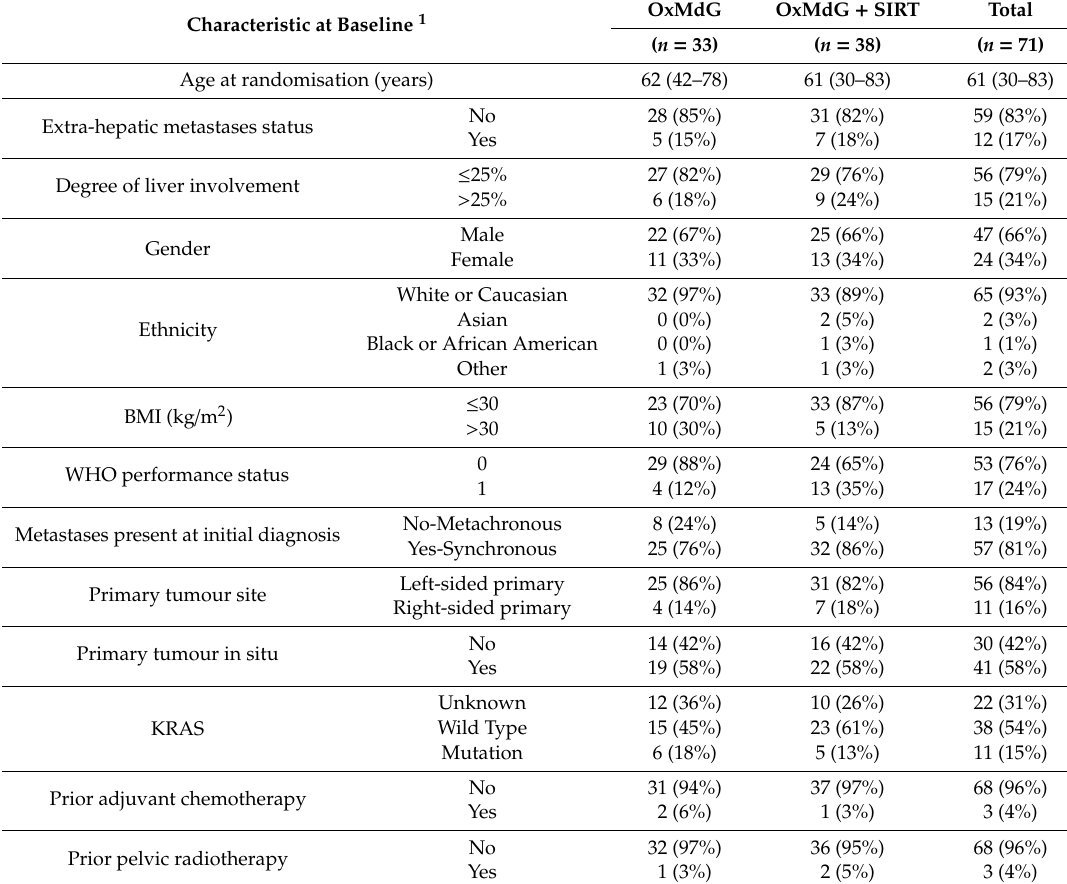
Table 1. Demographics of the study participants who had hepatic resection during the FOXFIRE clinical